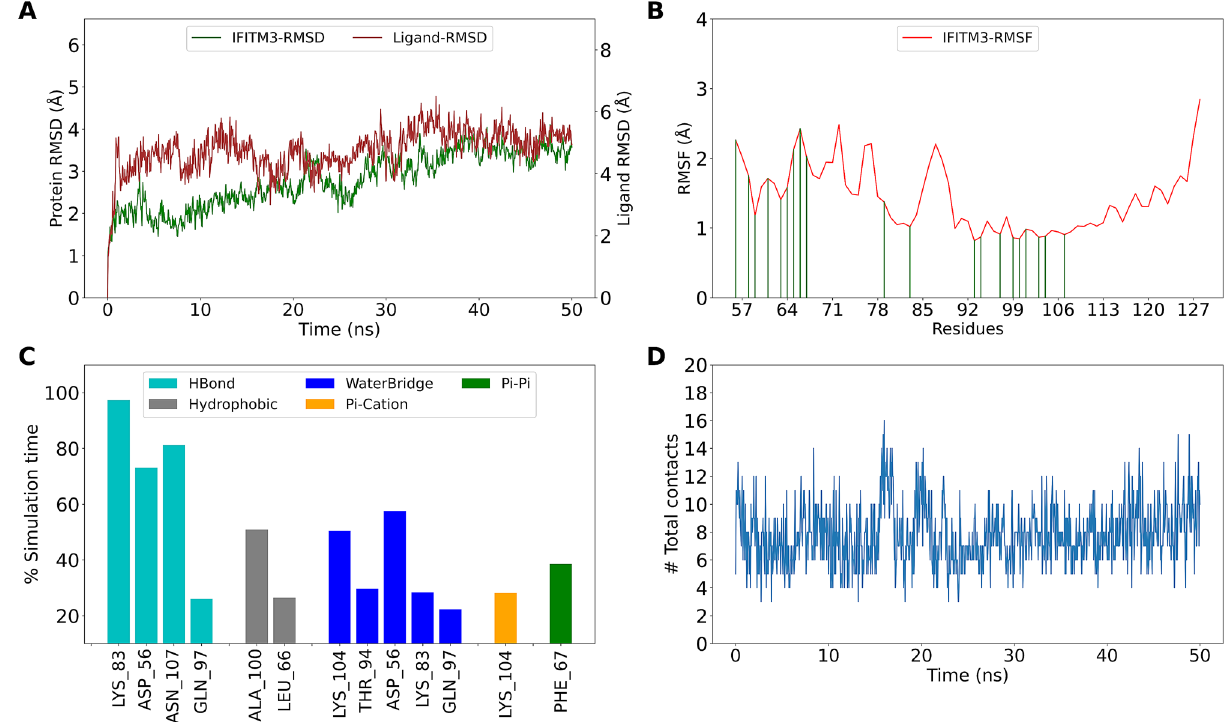
Figure 5. MD simulation of IFITM3-Eluxadoline complex ( A ) RMSD of IFITM3 and Eluxadoline fit on IFITM3 (Ligand-RMSD) ( B ) RMSF of IFITM3. Green lines indicate interactions with Eluxadoline ( C ) Interactions between IFITM3 and Eluxadoline as percentage of simulation time. Interactions that persist for more than 20% of simulation time have been shown ( D ) Total contacts (includes all interactions) between Eluxadoline and